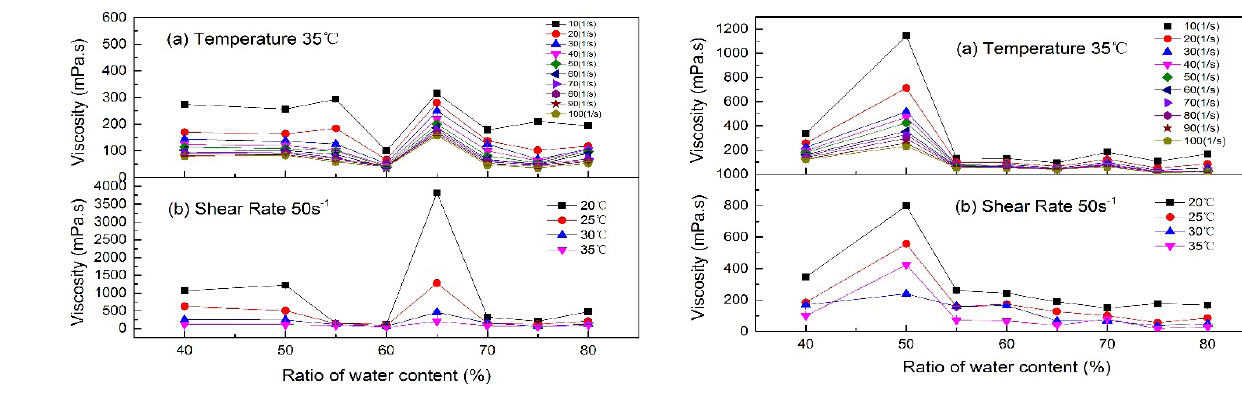
Figure 6: Dependencies of viscosity on the water content in the system of polymer concentration (315mg/L) and (a) temperature (35 ) (b) shear rate (50s -1 ). ℃